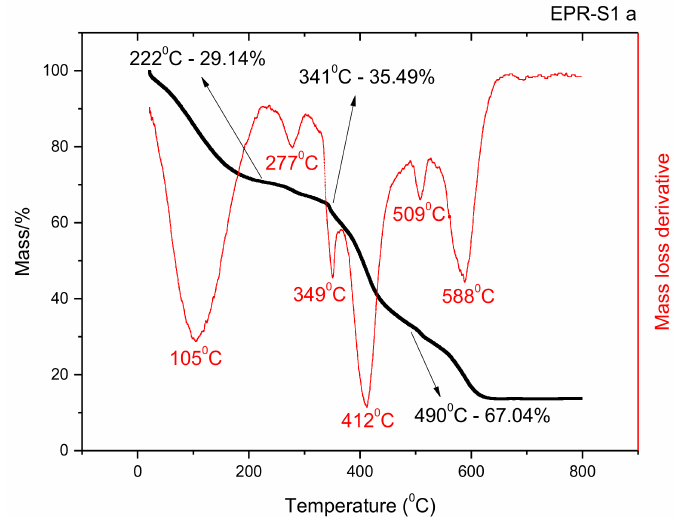
Figure 6. Thermo gravimetric analysis (TGA) and derivative curve from sample